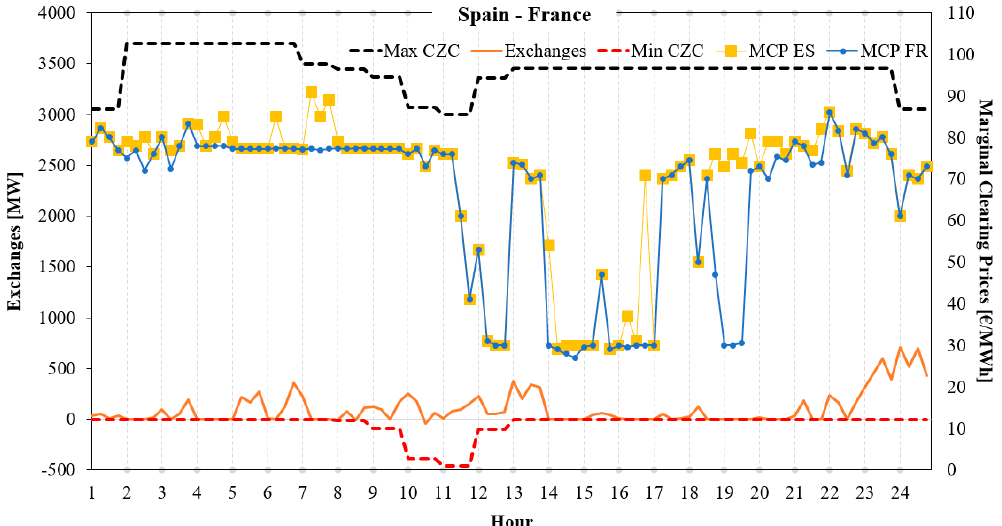
Figure 18. Exchanges in the interconnection Spain–France and respective BE clearing prices.